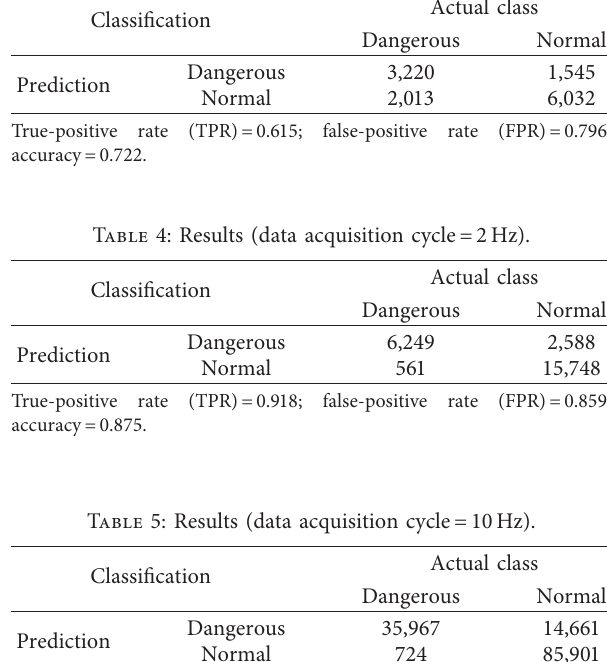
Table 3: Results (data acquisition cycle � 1Hz). Classification